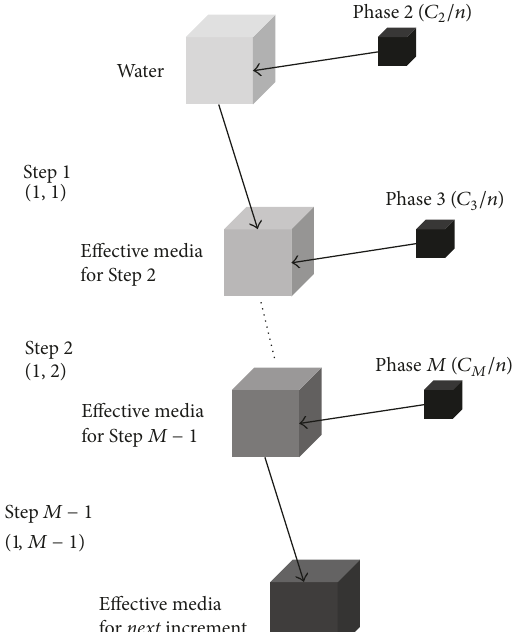
Figure 2: Schematic diagram showing the steps used in the first increment in the multiphase anisotropic dielectric model, in which water is the starting medium. The effective media formed in the last step of each increment become the starting background for the next increment, after Han et al. [28,